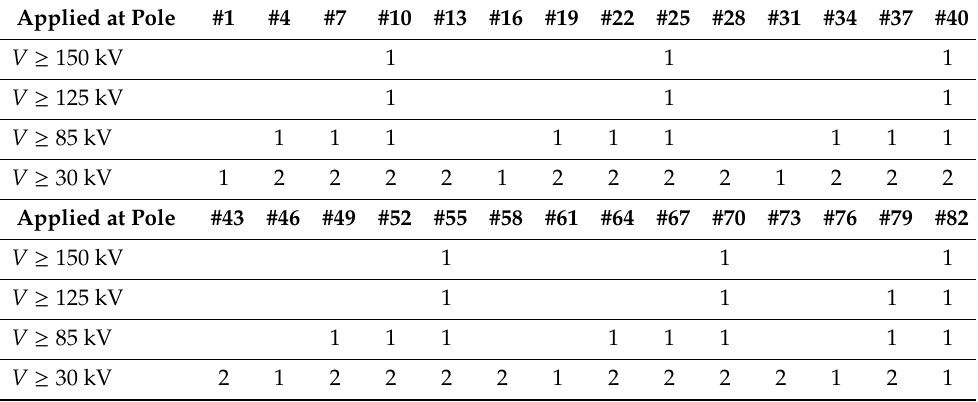
Table 5. Number of transformers with at least one phase reaching the critical overvoltage level. Case 2, wet creosote-impregnated poles and grounding one intermediate pole between two transformer poles.